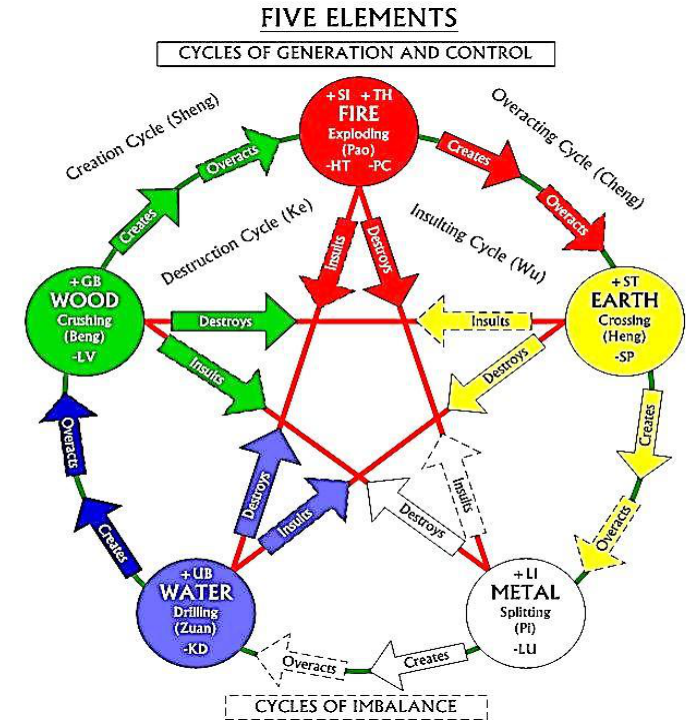
Figure 1. Five Elements of cycles (Author: Don Reynolds, March 2007